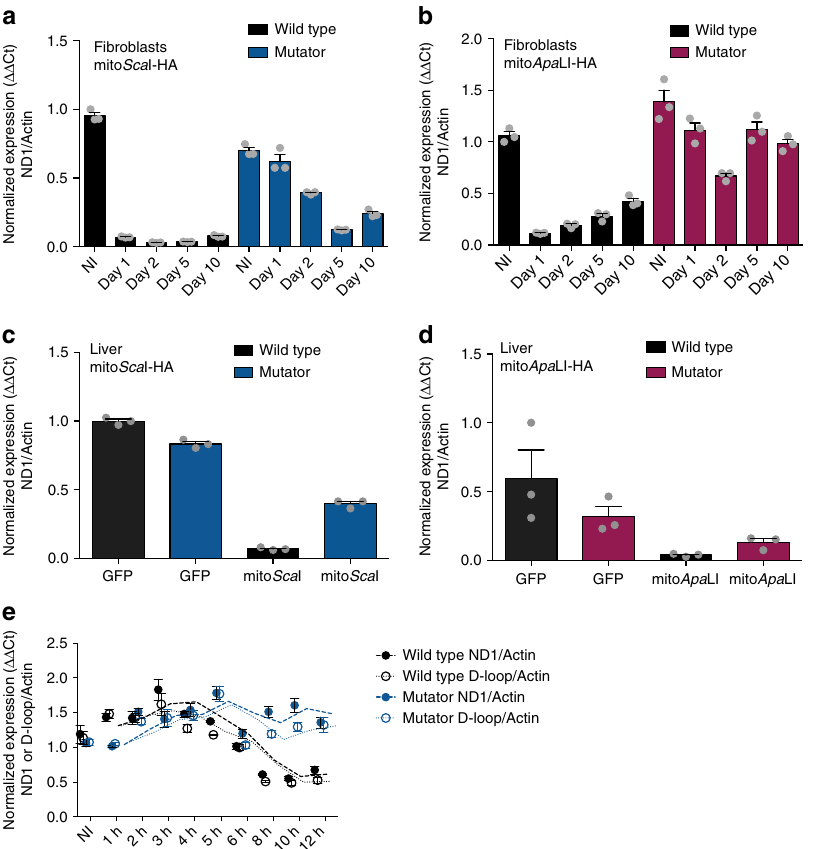
Fig. 3 Quanti fi cation of mtDNA levels after DSB in the mutator mouse. Relative levels of total mtDNA were assessed using ND1 (mtDNA) and β -Actin (nuclear DNA) primers in a mutator and wild-type fi broblasts infected with Ad-mito Sca I-HA at 1, 2, 5, and 10 days post-infection; b mutator and wild-type fi broblasts infected with Ad-mito Apa LI-HA at 1, 2, 5, and 10 days post-infection; c mutator and wild-type liver of mice infected by retro-orbital injection with Ad- GFP or Ad-mito Sca I-HA at 5 days post-injection; d mutator and wild-type liver of mice infected by retro-orbital injection with Ad- GFP or Ad-mito Apa LI- HA at 5 days post-injection. e Relative levels of total mtDNA were assessed using ND1 or D-loop (mtDNA) and β -Actin (nuclear DNA) primers in mutator and wild-type fi broblasts infected with Ad-mito Sca I-HA at 1, 2, 3, 4, 5, 6, 8, 10, and 12 h post-infection. Dashed line indicates the moving average for the two time points fl anking the time point of interest. NI indicates not infected. Quanti fi cation was performed using comparative ΔΔ Ct method. Error bars (s. e.m.) derive from technical